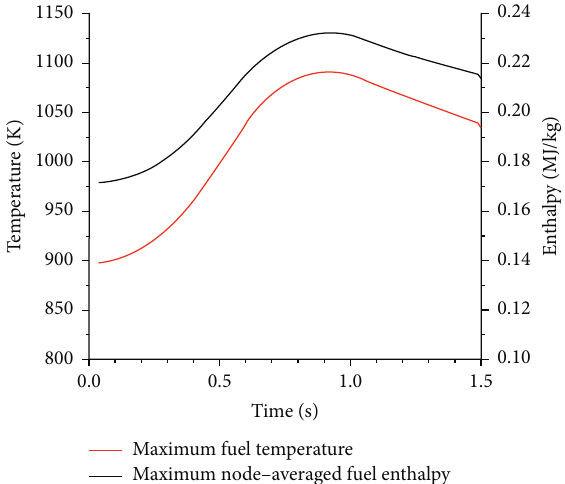
Figure 7: The maximum fuel temperature and enthalpy for the fast